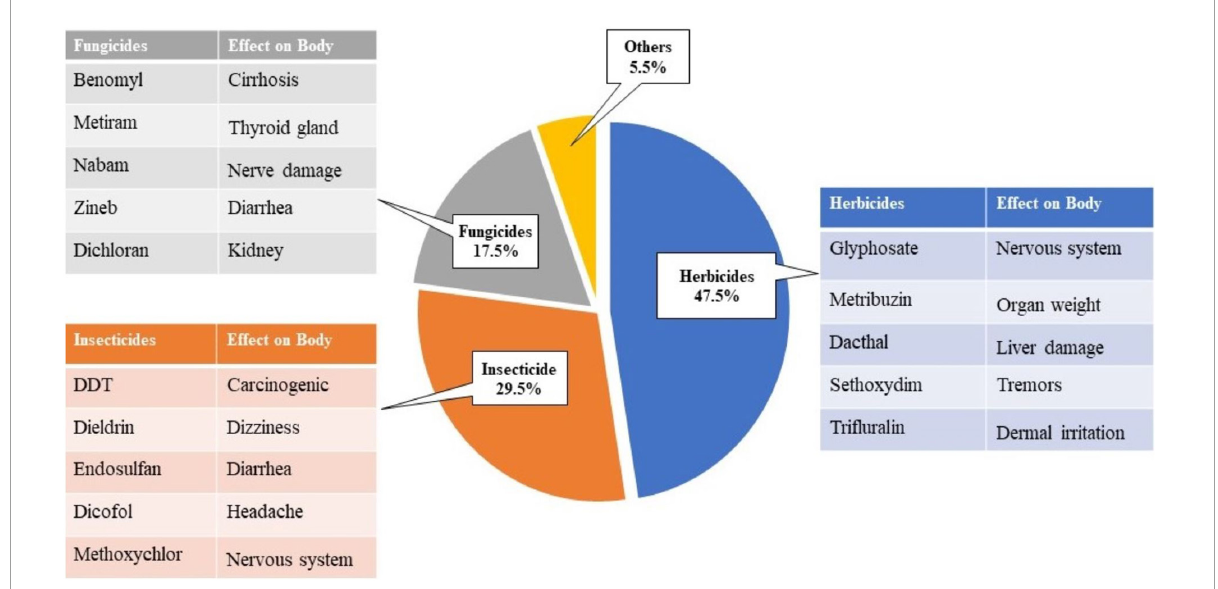
FIGURE1 Percentage distribution of pesticides (Nicolopoulou-Stamati et al., 2016; Alengebawy et al., 2021).